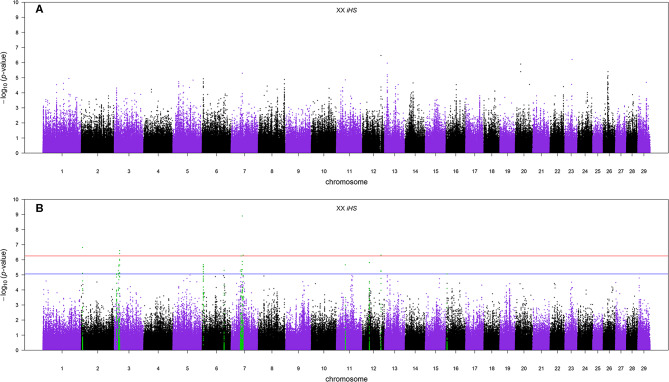
(A) The Manhattan plot of p-values for genome-wide iHS scores calculated using all samples and (B) the Manhattan plot of p-values for genome-wide iHS scores calculated using only admixed cattle with three or more crossovers per Morgan. The red and blue horizontal lines are false discovery rate thresholds at 0.05 [−log10(p-value) = 6.25] and 0.10 [−log10(p-value) = 5.06], respectively. Green points are the SNPs within the candidate regions identified as being under selection.